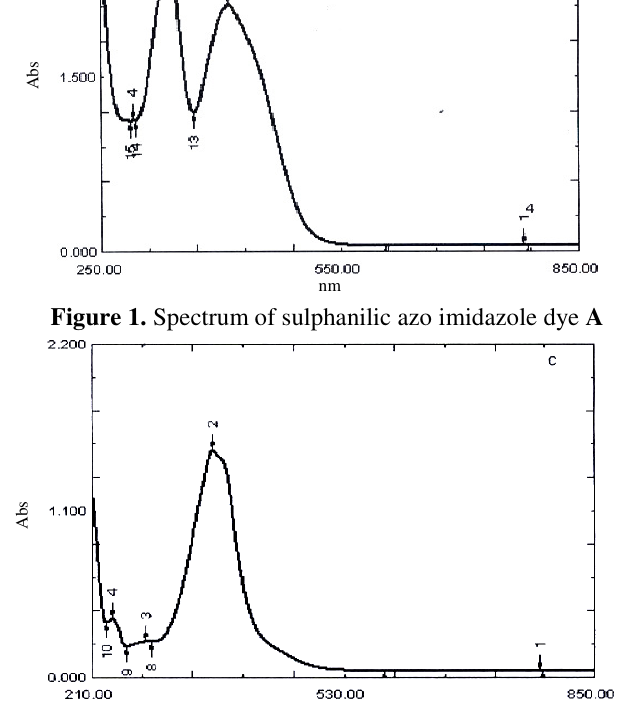
Figure 2. Spectrum of sulphanilic azo antipyrine dye